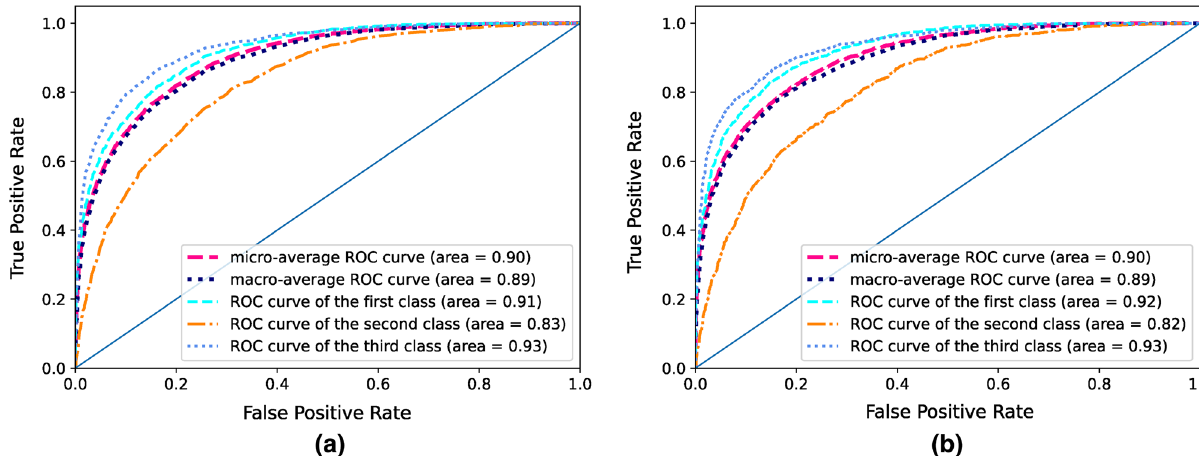
Figure 6. ROC curves of the ( a ) random forest ( b ) LightGBM classification models which is trained to predict the blood creatinine level in three classes. The ROC curves obtained using micro-averaging and macro- averaging methods are plotted along with binary classification ROC curves of each class against other classes.